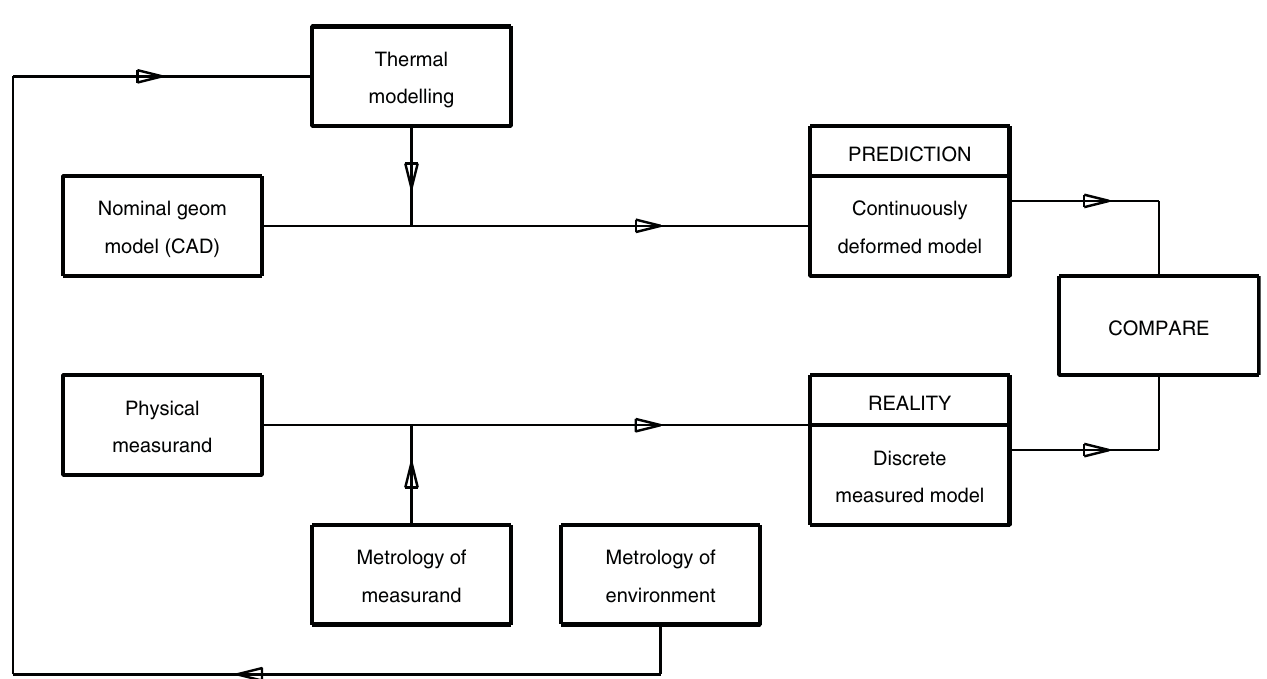
Fig. 2. Hybrid approach to dimensional metrology.